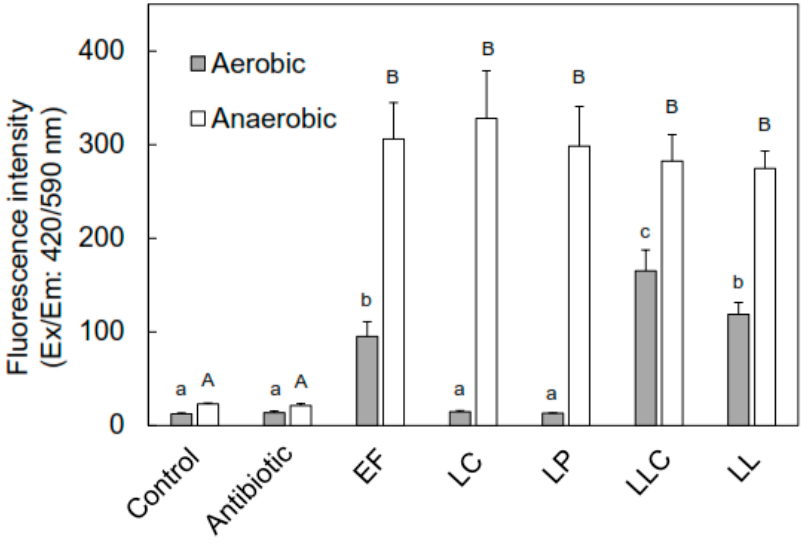
Figure 5. Effects of oxygen on ZnPP formation by the ZnPP-forming LAB in porcine Longissimus thoracis et lumborum (LTL) muscle homogenate. A mixture containing the final concentrations of 20% pork homogenate, 3% salt, and 2.0 × 10 6 CFU/mL of respective LAB was incubated both aerobically and anaerobically at 25 °C for 7 days in the dark. After incubation, ZnPP of the mixture was extracted using the 75% acetone method, and the fluorescence intensity (Ex/Em: 420/590 nm) was measured. Bars represent the standard error of the means ( n = 3). a–c and A–B: columns with different letters in the different groups differ significantly ( p < 0.01). ZnPP: zinc protoporphyrin IX, LAB: lactic acid